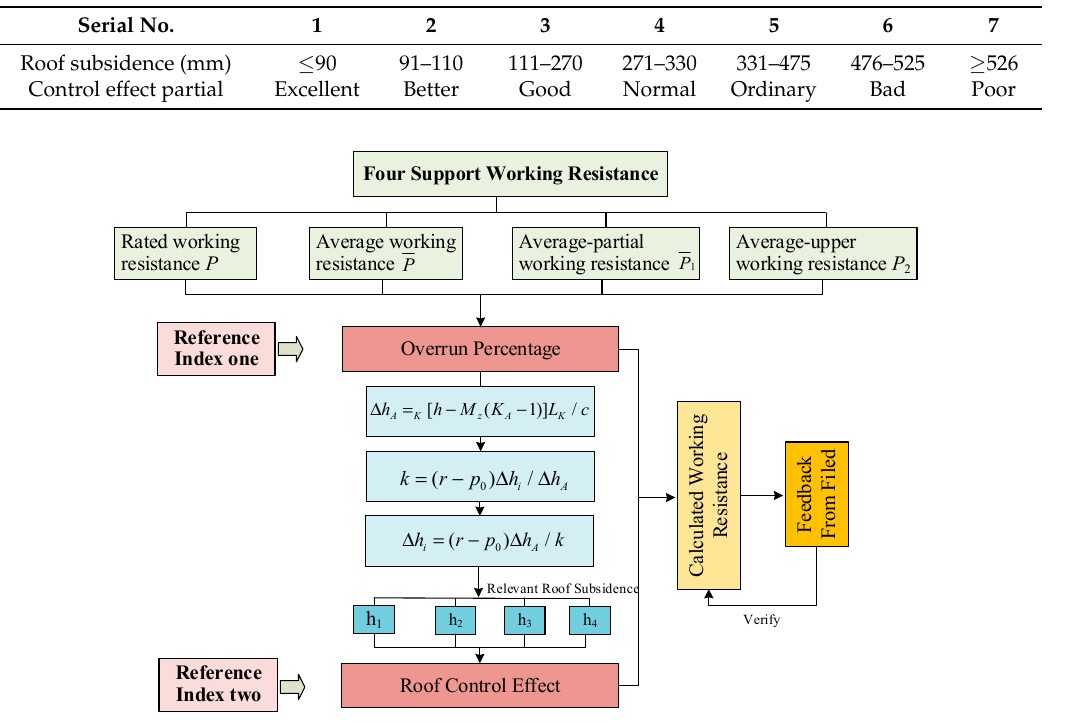
Figure 4. Working resistance design flow.